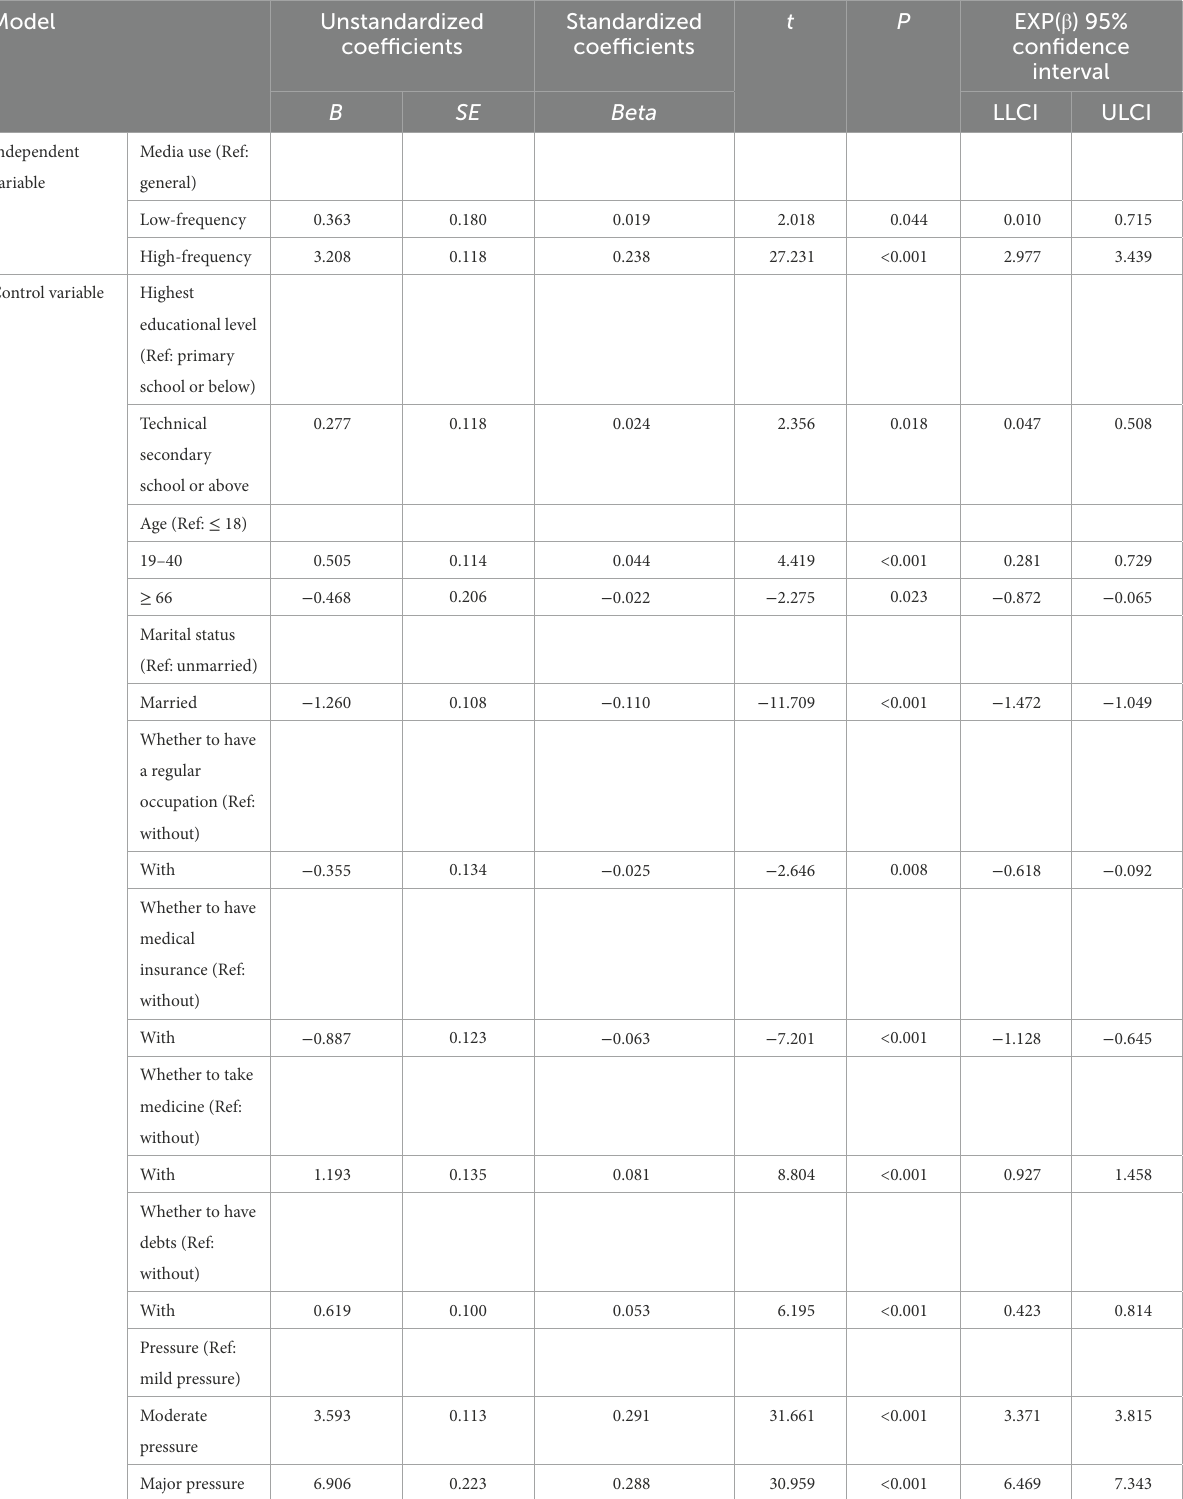
TABLE 4 Regression model of demographic and social factors and other scale scores to depression